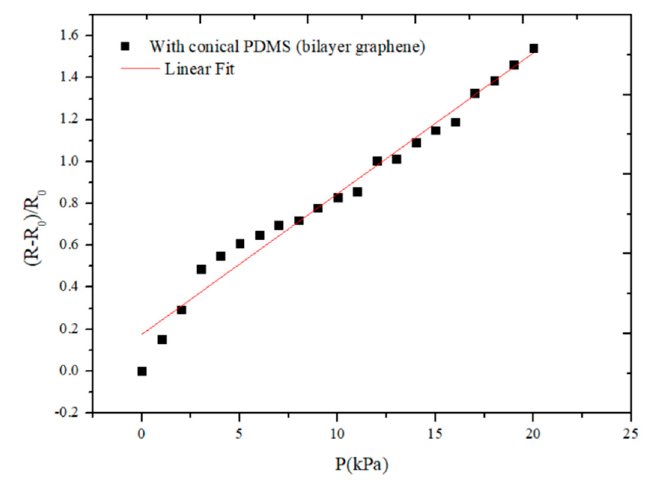
Figure 10. The linearity curve of the flexible sensor.